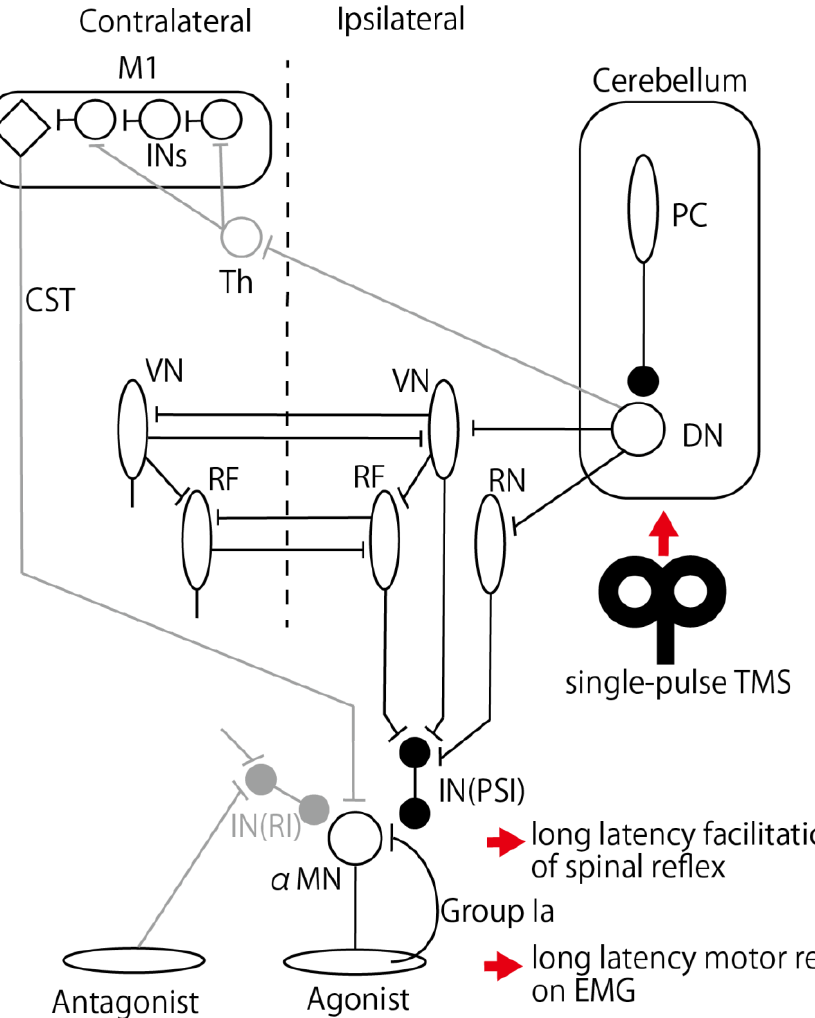
Figure 5. Possible pathway underlying the long-latency motor response on an EMG and the long- latency facilitation of the spinal reflex following cerebellar conditioning TMS. The black line indicates the possible pathway, and the gray line indicates the redundant pathways. M1, primary motor cortex; Th, thalamus; CST, corticospinal tract; PC, Purkinje cell; DN, deep cerebellar nucleus; VN, vestibular nuclei; RF, reticular formation; RN, red nuclei; IN, interneuron; PSI, presynaptic inhibition; RI, reciprocal inhibition; α -MN, alpha motoneuron; Agonist, agonist’s muscle; Antagonist, antagonist’s muscle; TMS, transcranial magnetic stimulation.